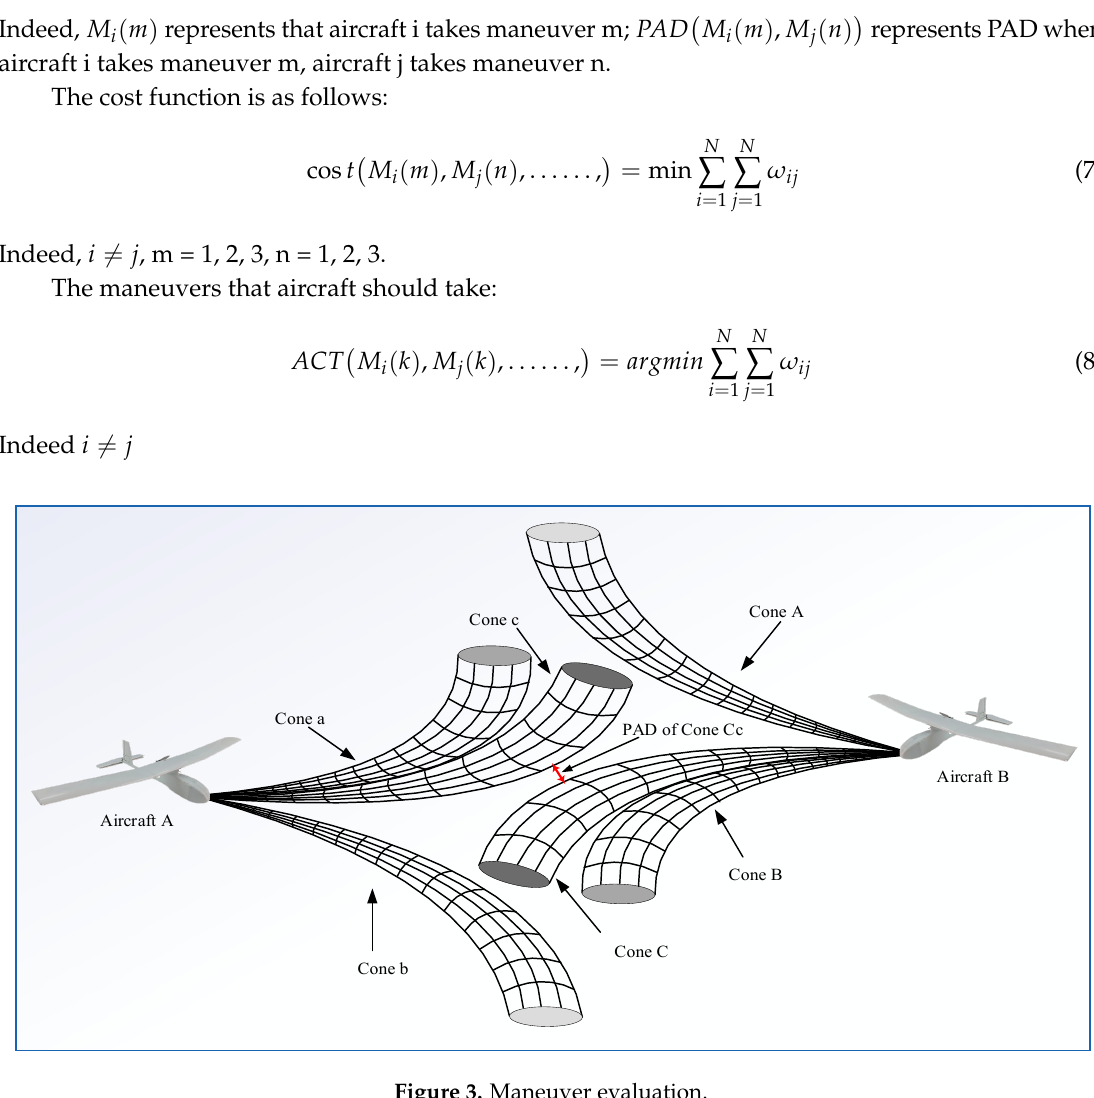
Figure 3. Maneuver evaluation.